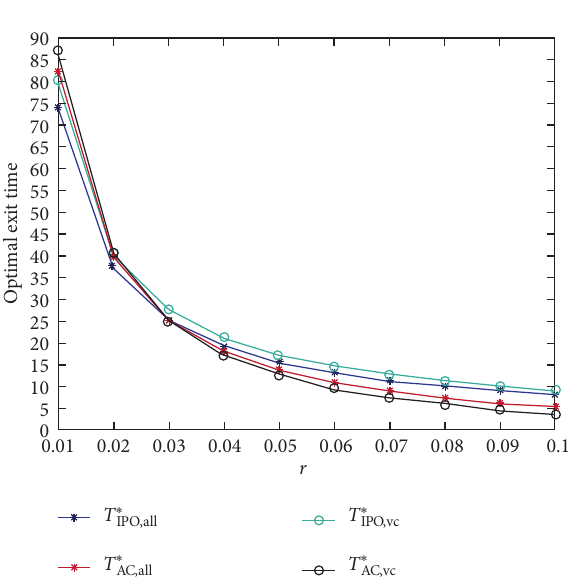
Figure 13: The optimal exit